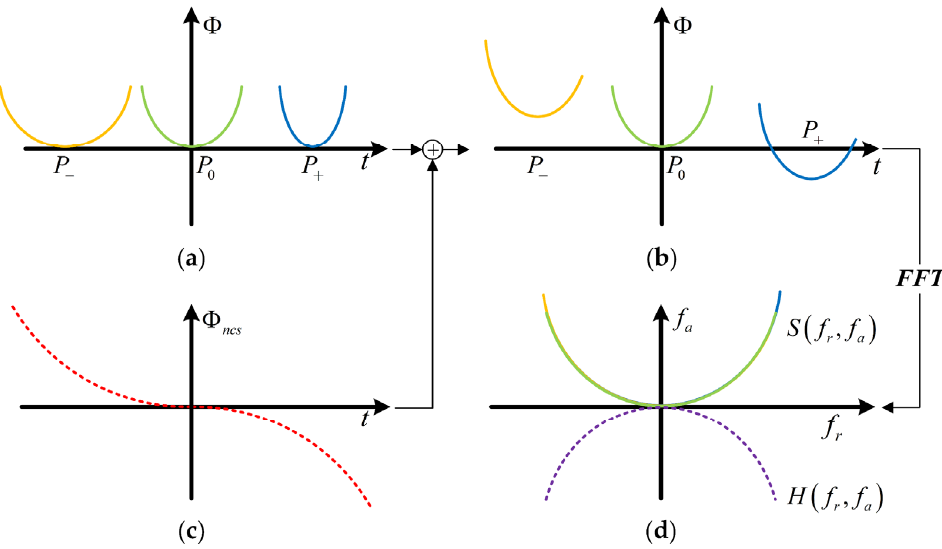
Figure 4. Diagrams for the processing of NLCS. ( a ) The quadratic phase of targets P − , P 0 , P + in the time domain; ( b ) Quadratic phase of targets P − , P 0 , P + after introducing the NLCS factor in the time domain. ( c ) NLCS factor; and ( d ) Uniform phase filtering in the frequency domain. In (12), it can be seen that the original range FM rate becomes the additional second-